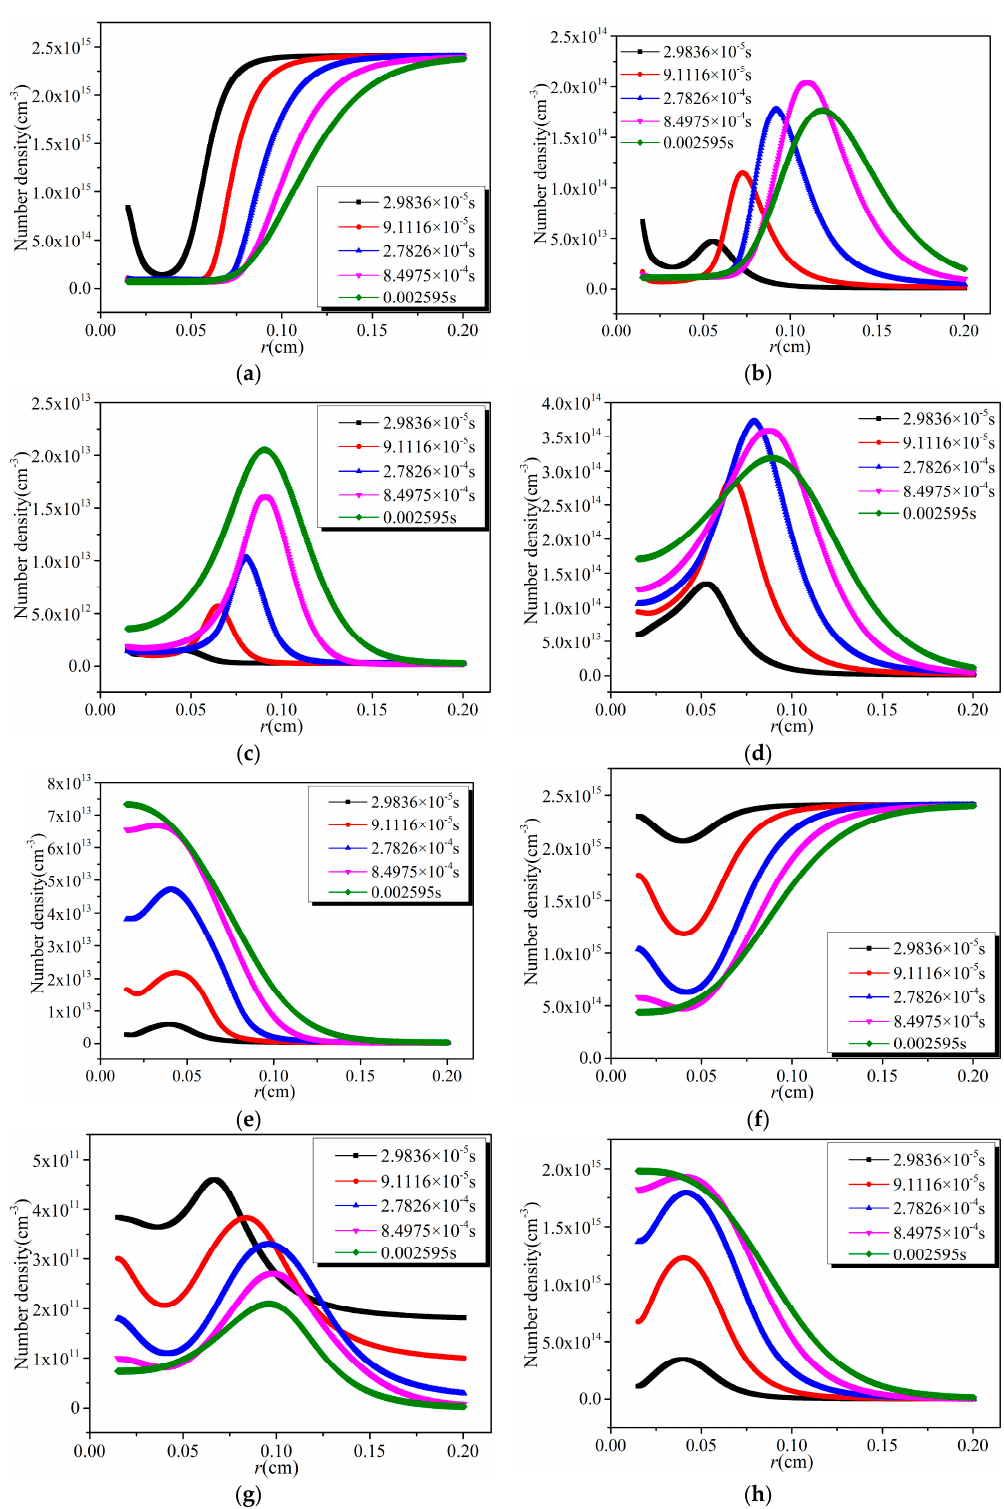
Figure 10. Distribution of the number densities of NO, SO 2 , and their main oxidation and reduction products by non-thermal plasma (NTP) at various time steps: ( a ) NO; ( b ) NO 2 ; ( c ) NO 3 +N 2 O 5 ; ( d ) HNO 2 +HNO 3 ; ( e ) N 2 O; ( f ) SO 2 ; ( g ) SO 3 ; and ( h ) HSO 3 +H 2 SO 4 .